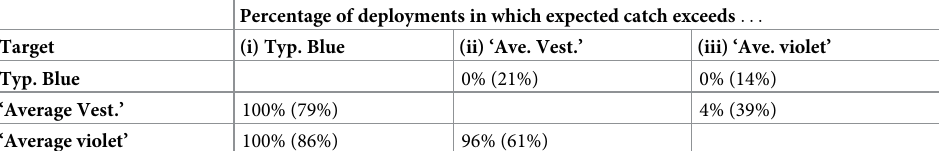
Table 9. Future target performance predicted by analysis of new data collected in Kenya, incorporating priors informed by analysis of previously published data [4]. Percentage of deployments in which expected catch exceeds ... Target (i) Typ. Blue (ii) ‘Ave. Vest.’ (iii) ‘Ave. violet’ Typ. Blue 0% (21%) 0% (14%) ‘Average Vest.’ 100% (79%) 4% (39%) ‘Average violet’ 100% (86%) 96% (61%) Table shows the percentage of 10,000 simulated catches in which the expected catch ( λ ) of the target in the row heading exceeded that in the column heading for the average catch replicate. Values in brackets indicate the same comparison of catch predictions, but incorporate the additional variability in tsetse catches across replicates estimated by the